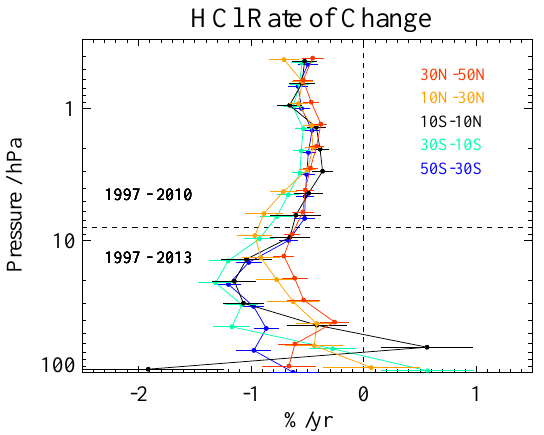
-2 -1 0 1 Figure 8. The average rate of change (percent per year) for HCl as a function of pressure for different latitude bin averages (see legend) for time periods corresponding to the appropriate GOZ- CARDS HCl values (see text) in the upper stratosphere (Jan- uary 1997–September 2010) and lower stratosphere (January 1997– December 2012). Deseasonalized monthly data were used to obtain a long-term trend for these time periods; 2 σ error bars are